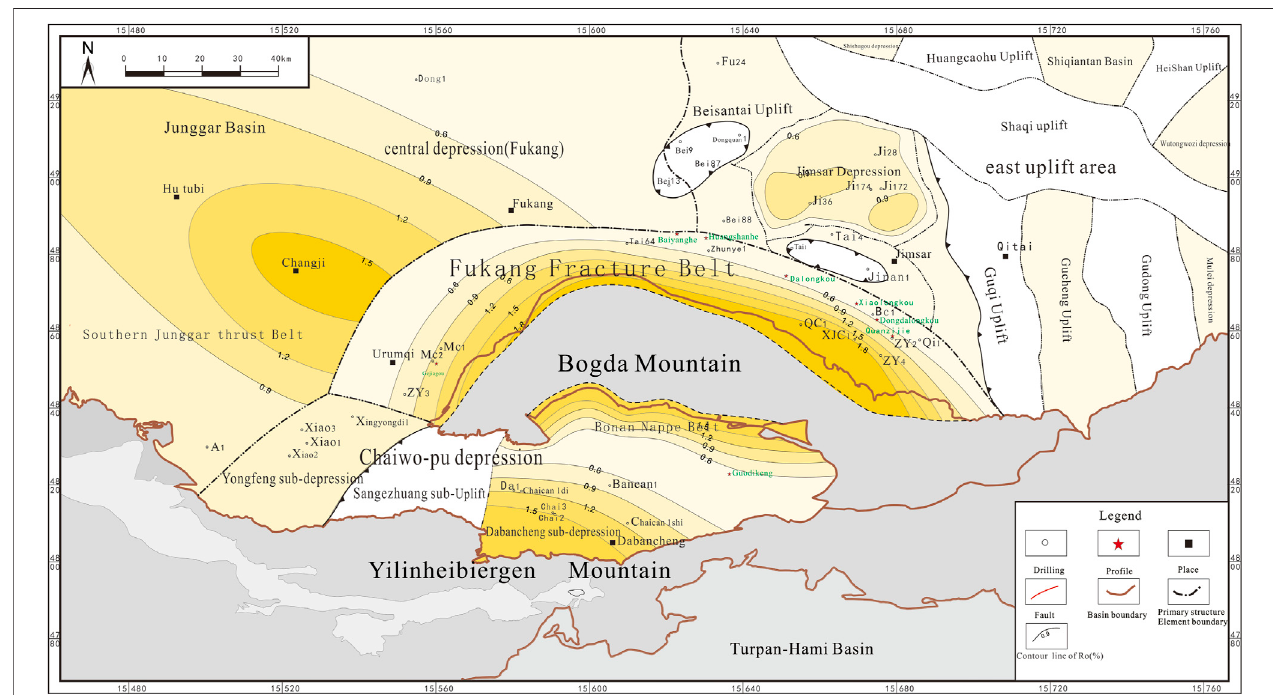
FIGURE 6 | Ro contour map of source rock of Lucaogou Formation.